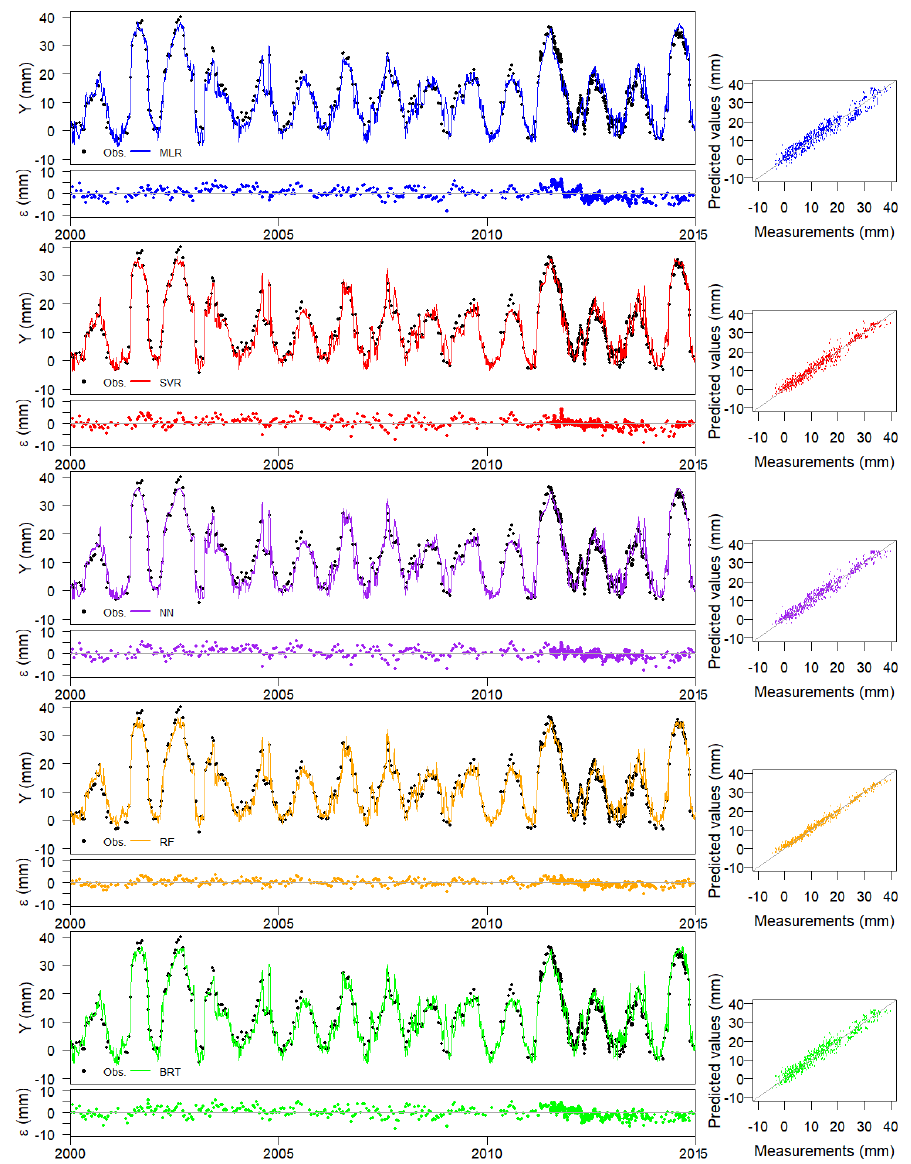
Figure 13. Measurements of the training set and output of the Machine Learning models for the horizontal upstream-downstream displacements at FP3/5–277.07 m base, block GH.